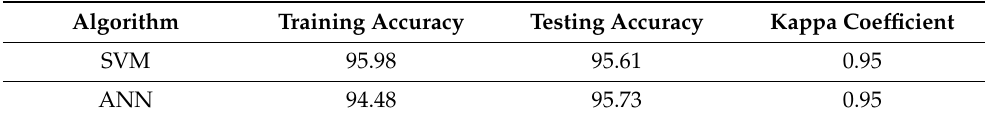
Table 3. Training, validation accuracies, and kappa coefficient of SVM and